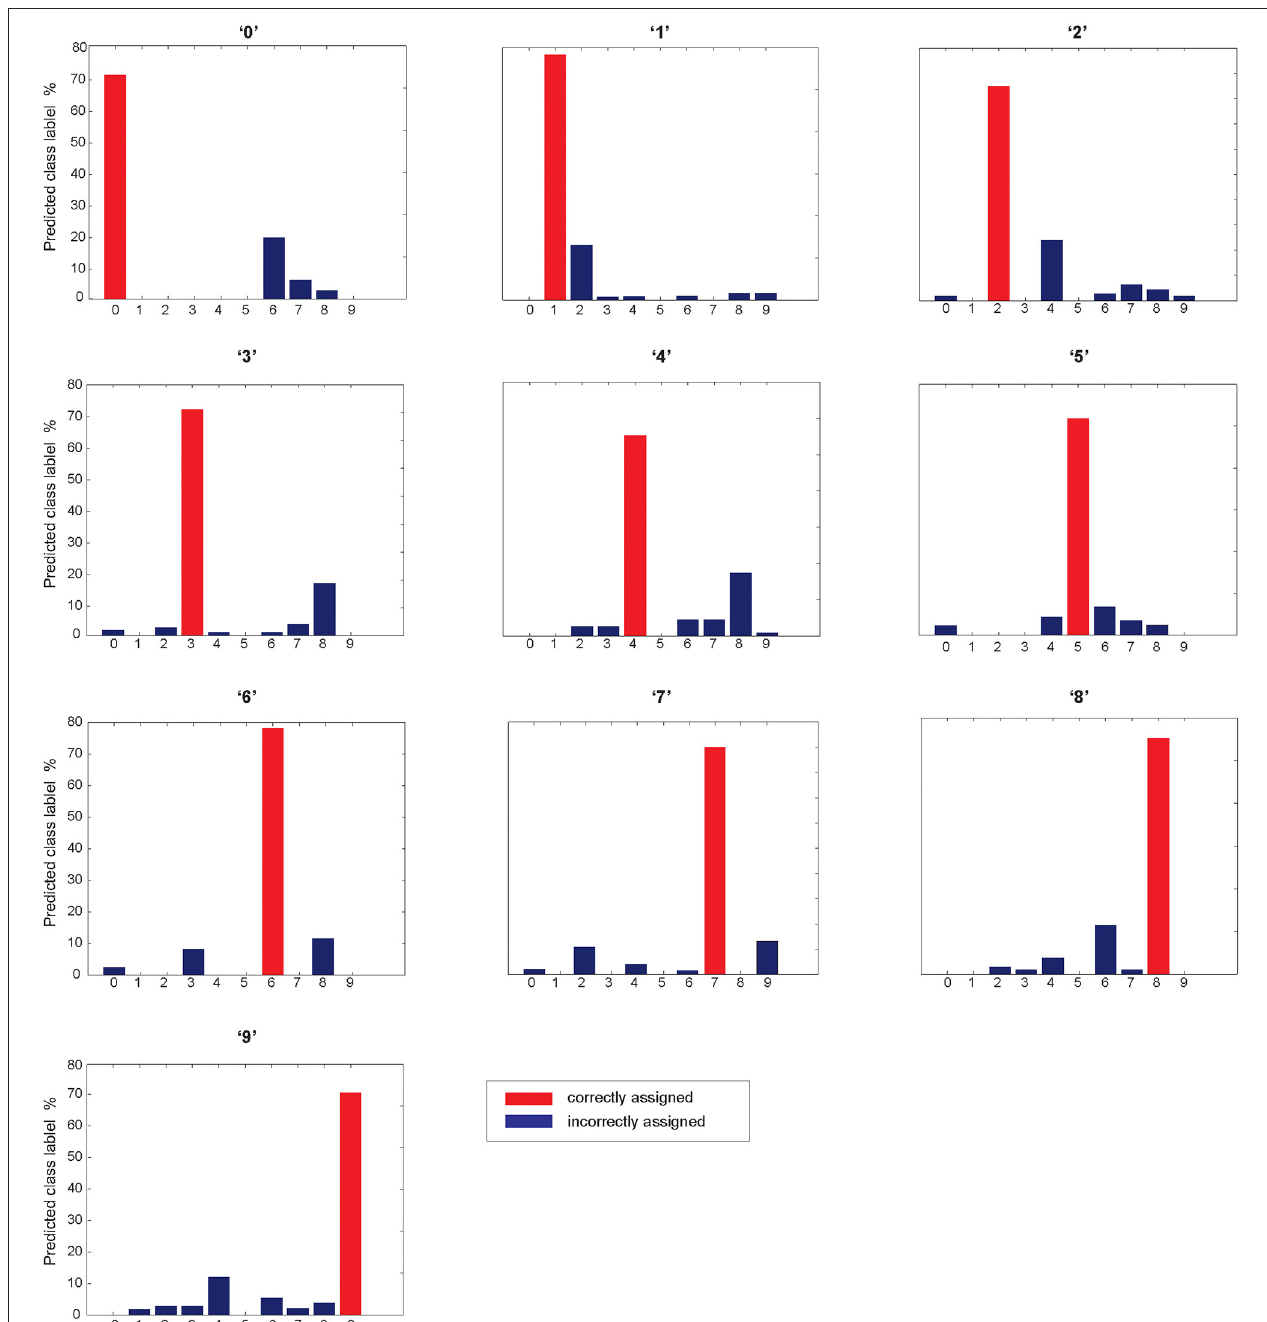
FIGURE 13 | Classification performance for individual digits class. Red bars show the performance of each digit class and blue ones are misrecognized samples assigned by the network. The model demonstrates that digit class “0” is mainly misrecognized with “6”; digit class “1” is misrecognized with “2”; digit class “2” is misrecognized with “4”; digit class ‘3” IS misrecognized with “8”; digit class “4” is misrecognized with “8”; and digit class “8” is misrecognized with “6”.